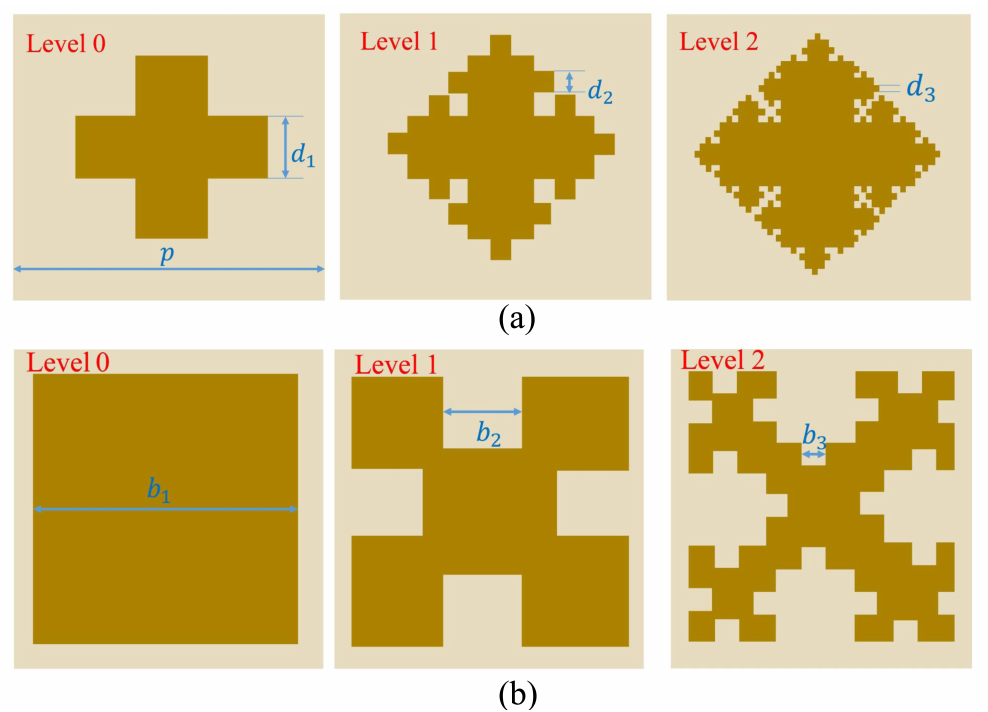
Figure 1. Koch curve-like and Minkowski geometry fractal iterations for levels 0, 1, and 2. ( a ) Koch curve-like fractal structure, ( b ) Minkowski fractal island